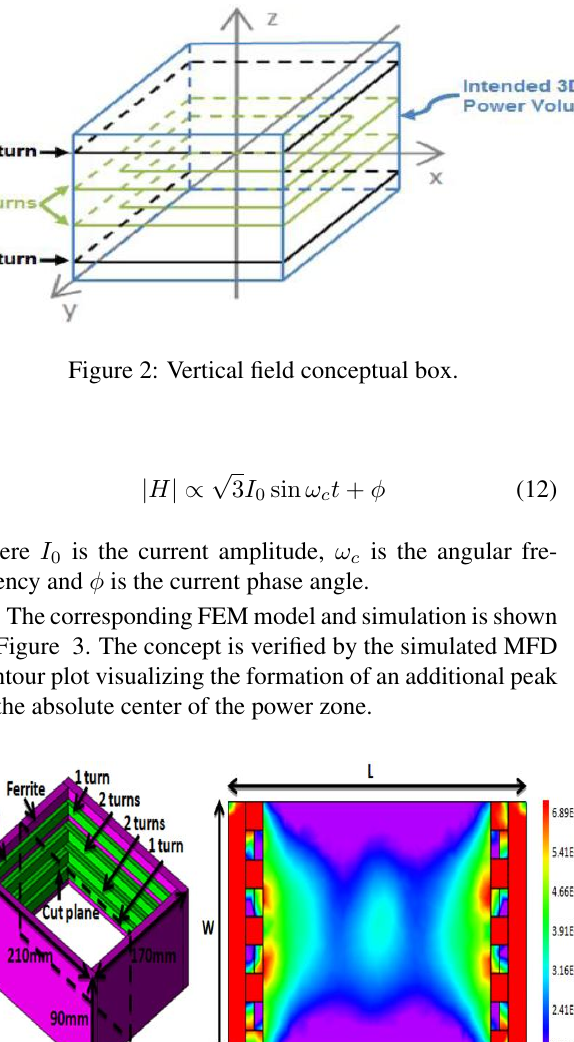
Figure 3: Vertical field FEM Model (left) and MFD distri- bution (right).